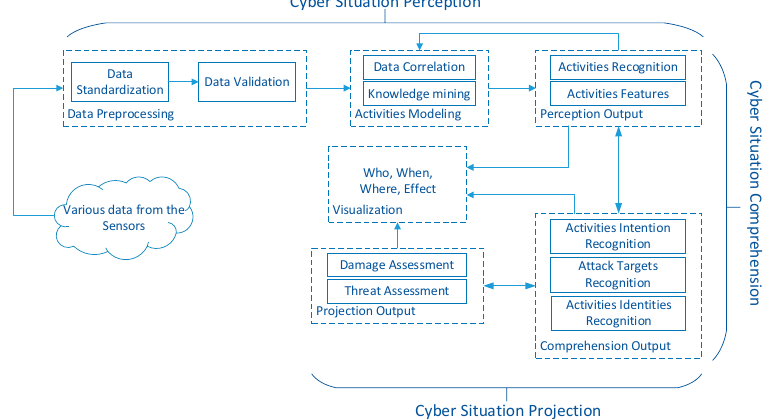
Figure 1. The framework of Cyber Situation Awareness.